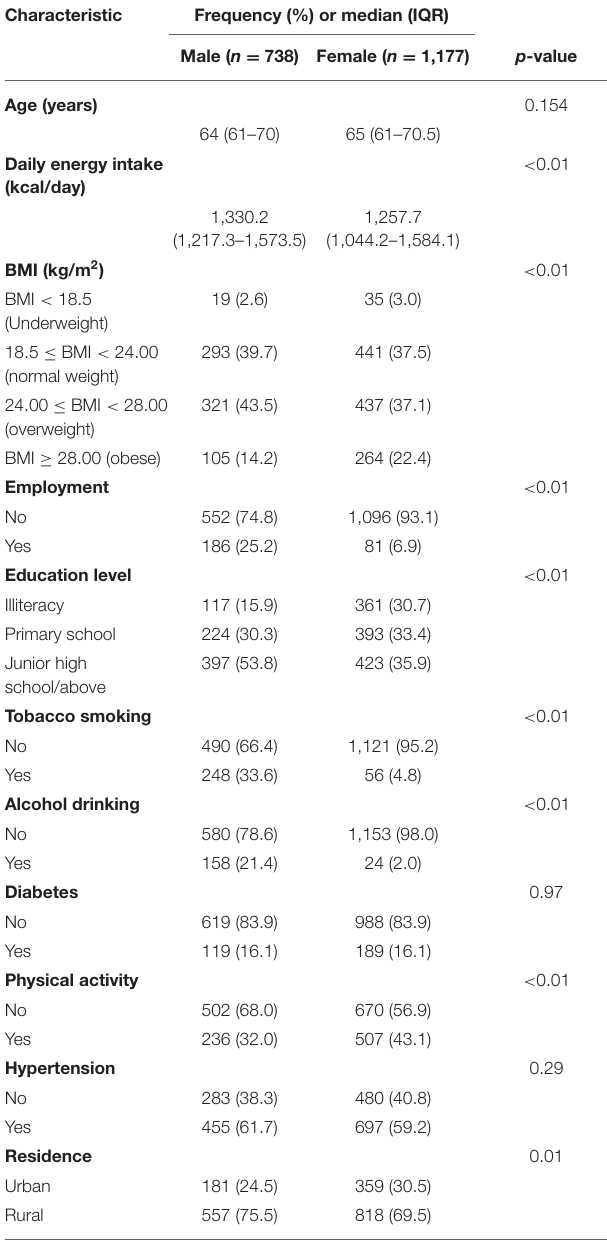
TABLE 1 | Characteristics of study participants of men and